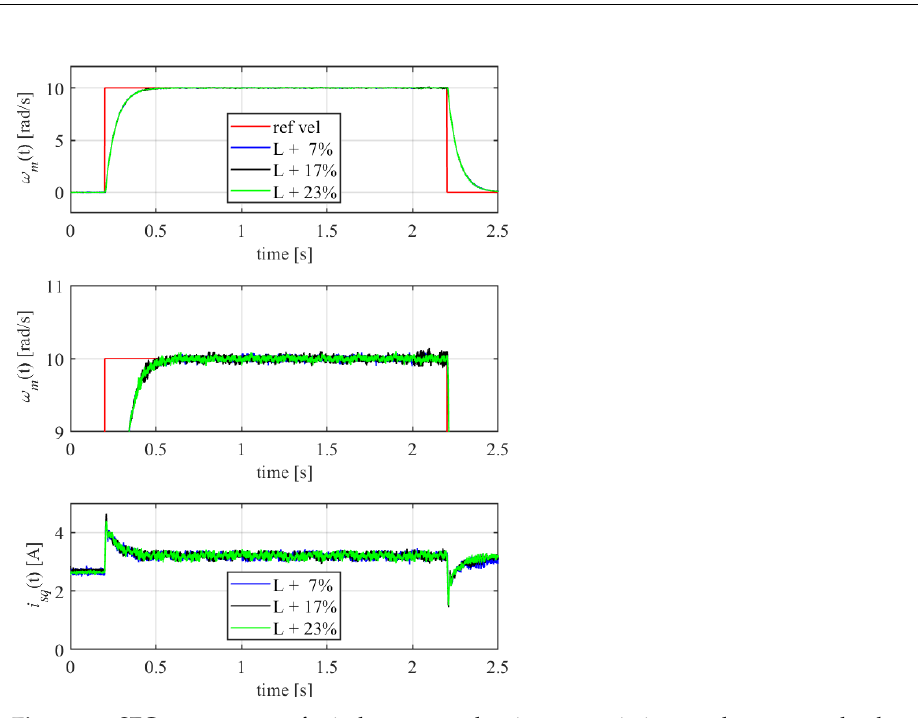
Figure 15. SFC step response for inductance and resistance variations under constant load operation.